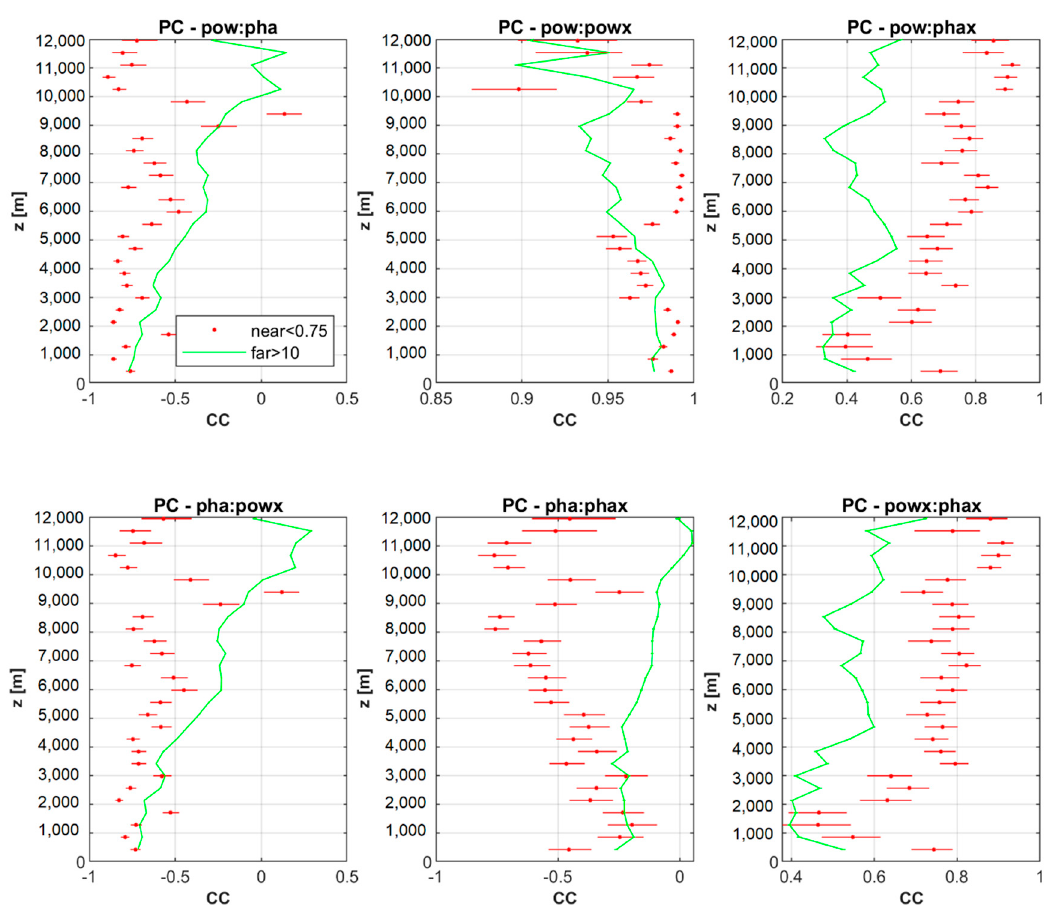
Figure 11. Correlations (CC) by Pearson (PC) between pairs of pow, pha, powx and phax in dependence on height (z [m]) above the radar site. Red points represent PC for “near(0.75 km)” data, while the green line indicates PC for “far” data. Horizontal lines shows 95% confidence intervals.